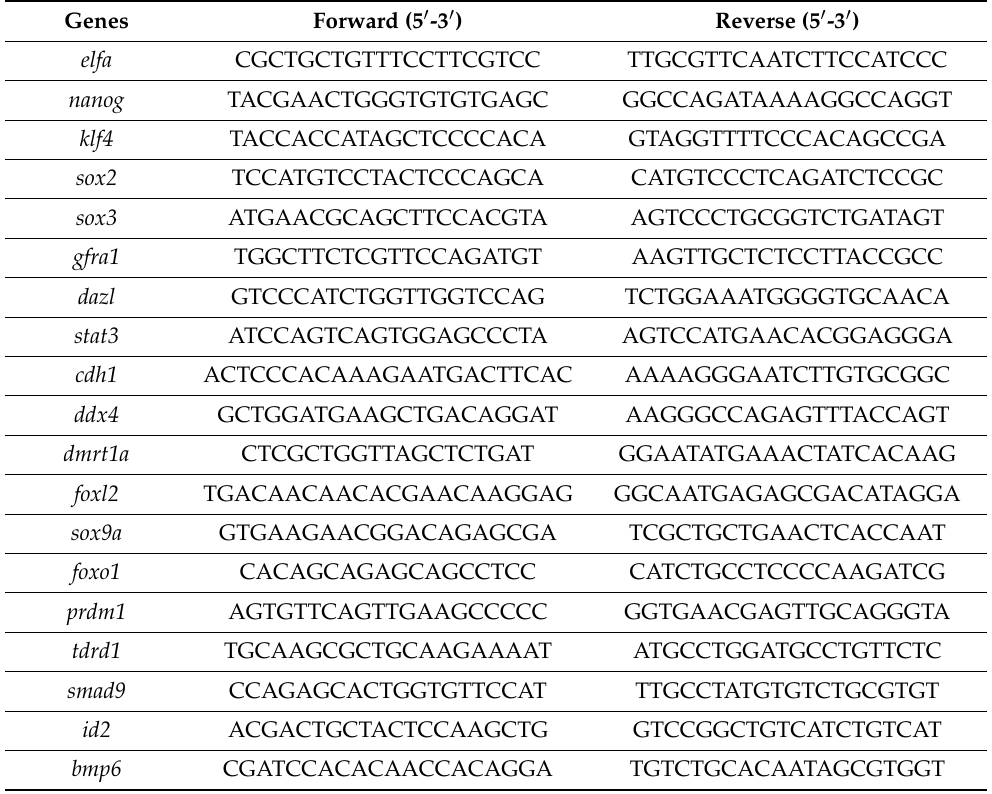
Table 1. The primers used for the RT-PCR analysis. Genes Forward (5 (cid:48) -3 (cid:48) ) Reverse (5 (cid:48) -3 (cid:48) )